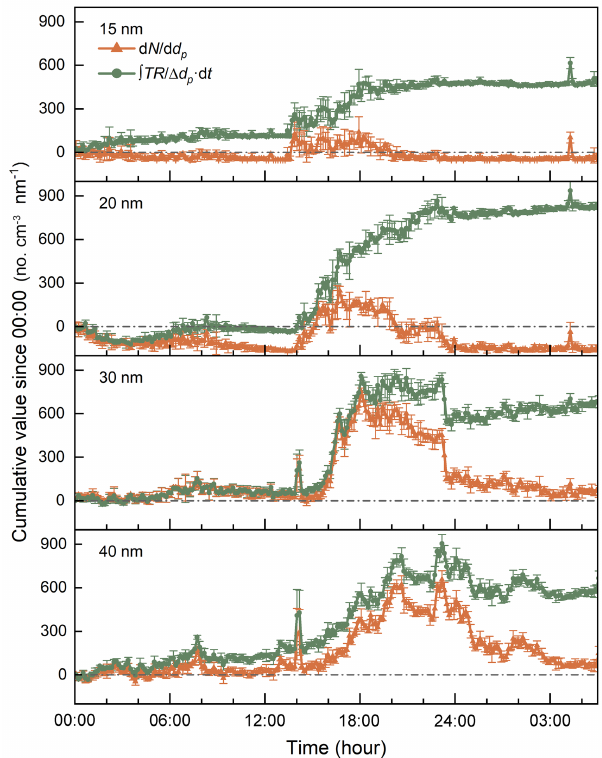
Figure 7. The time series of d N / d d p and the cumulative transport term on the 16–17 March 2015, at the Fukue Island. The d N /d d p and cumulative transport term were averaged every 9min. The error bars indicate the maximum and minimum values in the correspond- ing time